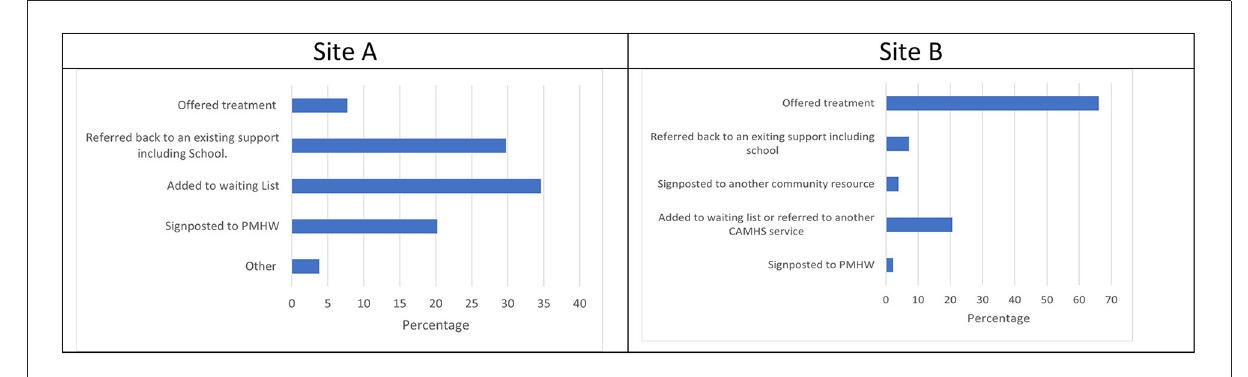
FIGURE6 (A,B) Referral